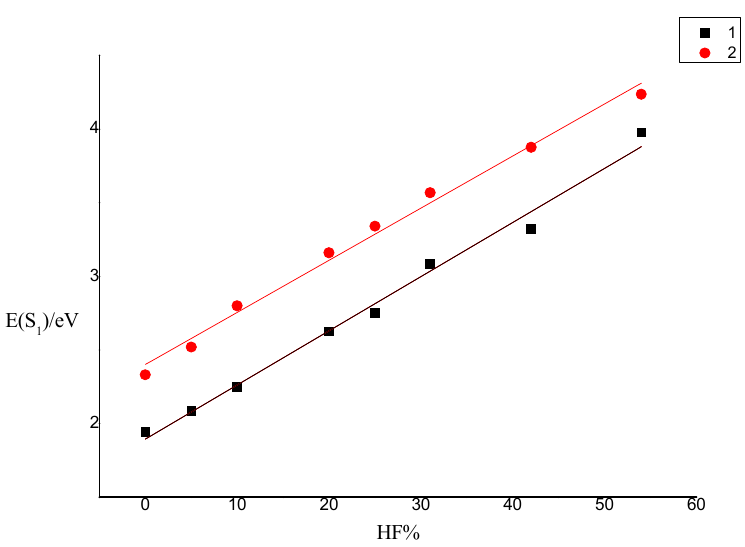
Figure 2. Dependence of E (S 1 ) of complex 1 on the HF% in TD–DFT functionals.